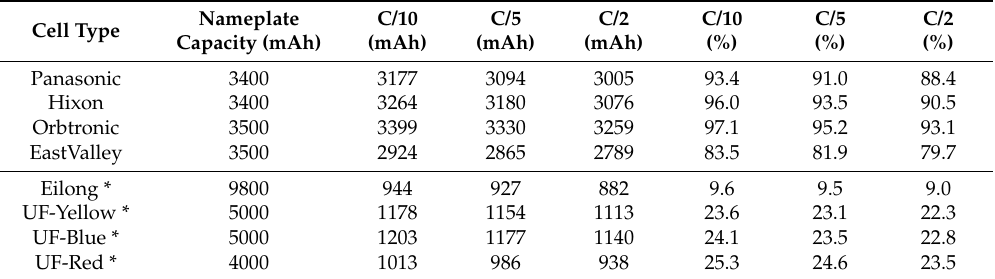
Table 3. Discharge performance compared to cell nameplate capacity. Discharge capacities are the average of two cells at each